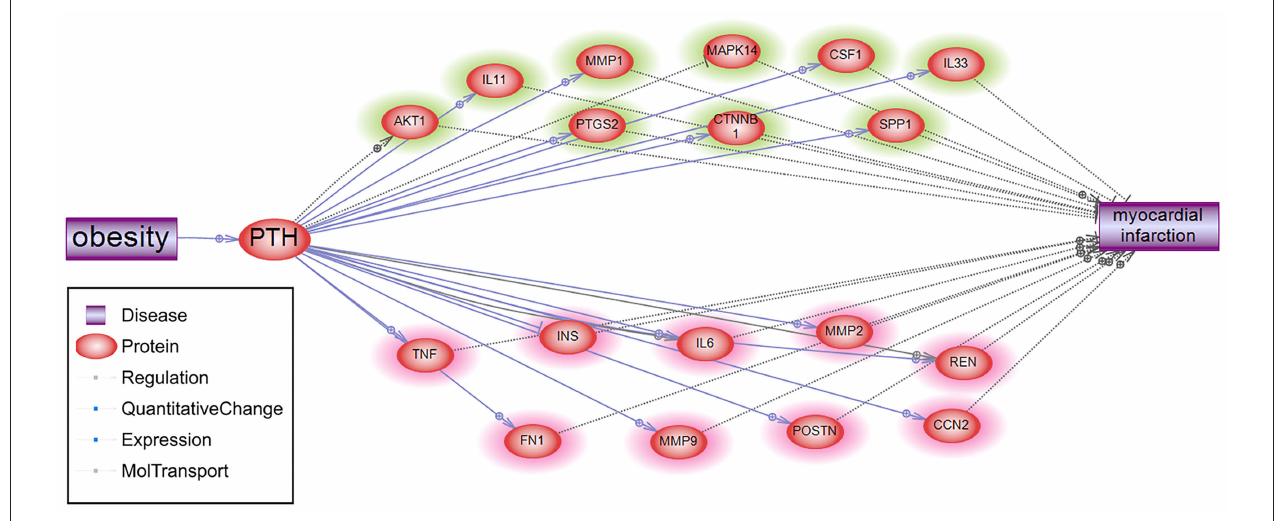
FIGURE 5 | Shortest path connecting obesity target PTH and